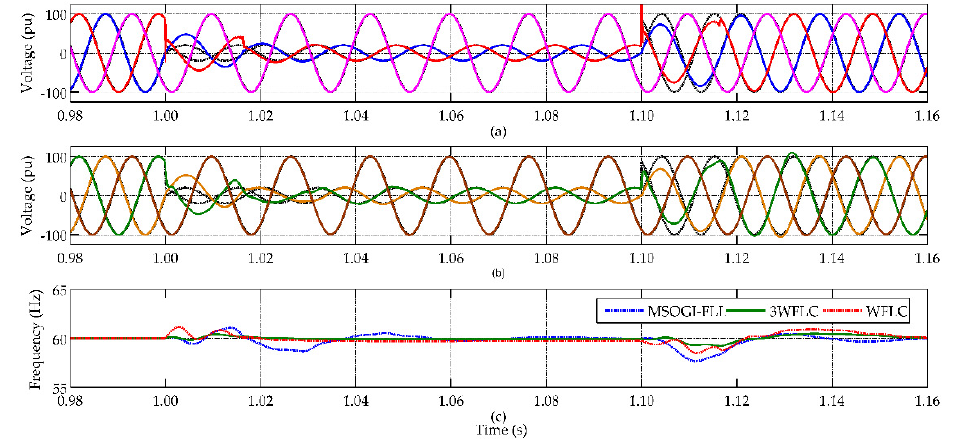
Figure 4. Results from simulation scenario 2, asymmetrical voltage drop. ( a ) SDFLC voltage outline in voltage drop; ( b ) MSOGI-FLL voltage outline in voltage drop; ( c ) Frequency transients during asymmetrical voltage drop.